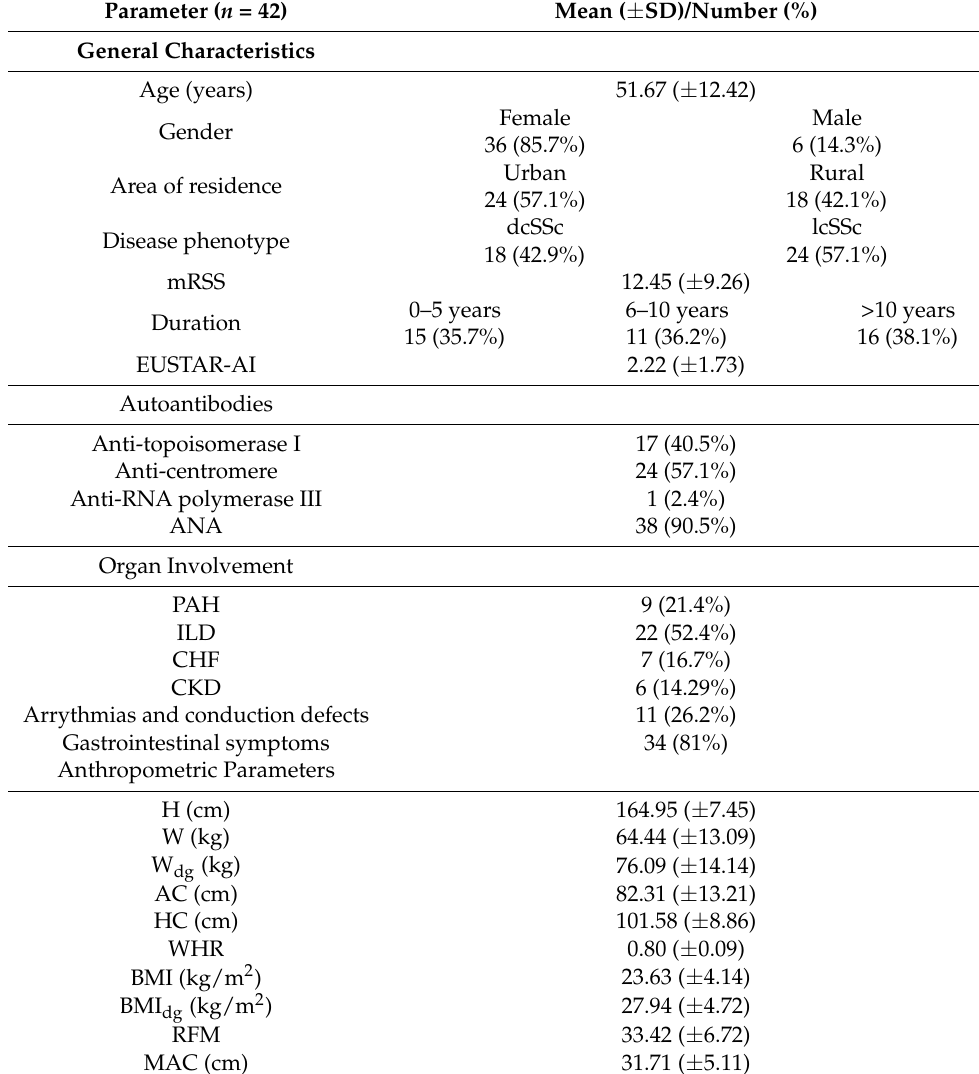
Table 1. Characteristics of the study